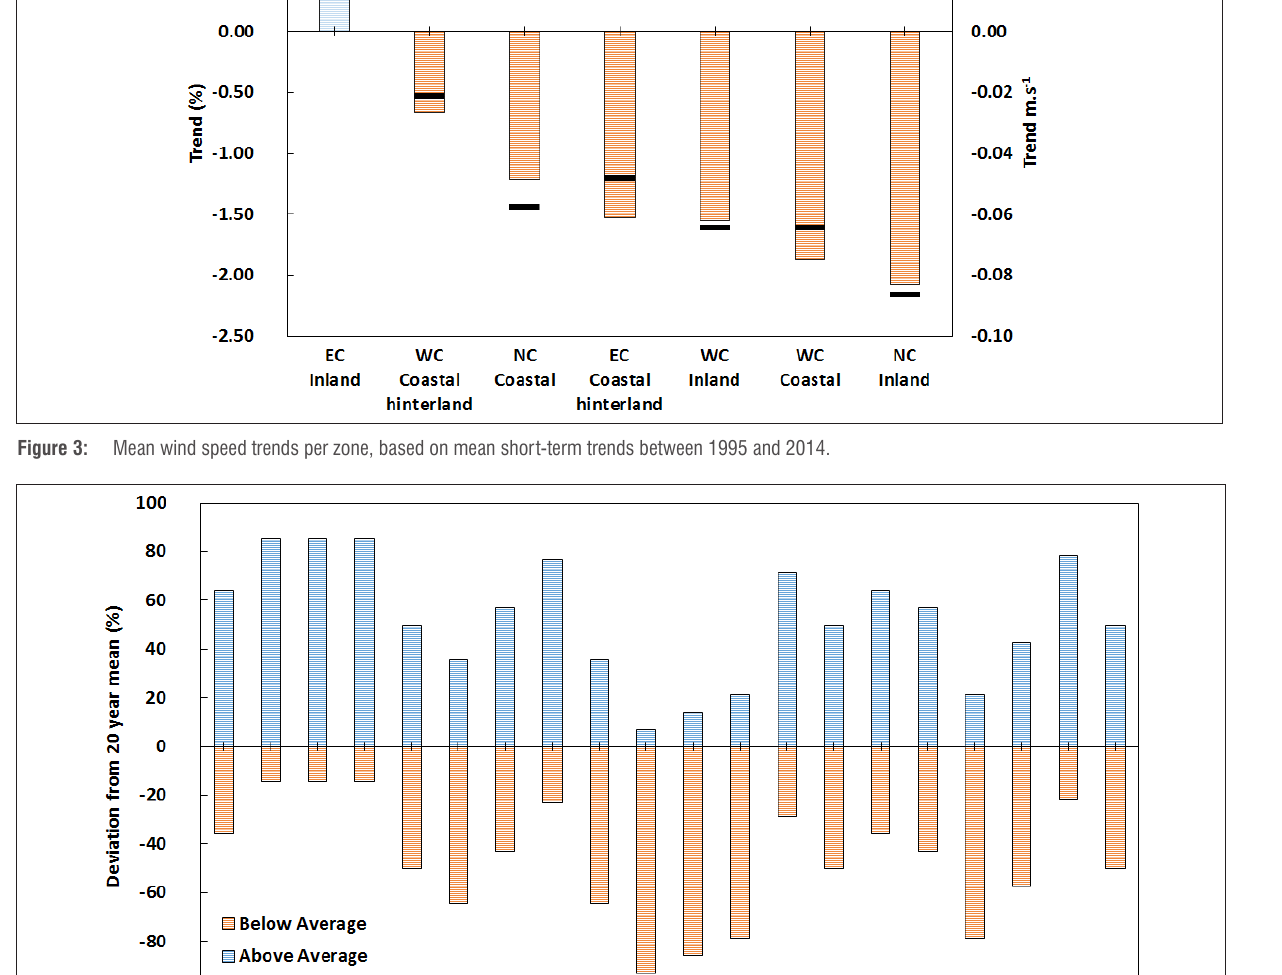
Over the 20-year period, mean annual wind speed trends were between -0.012 m/s/year (-0.31% pa) for Noupoort and 0.006 m/s/year (0.15% pa) for Langebaan, with a mean decrease across all stations of -0.002 m/s/year (-0.06%). The seasonal mean wind speed trends ranged from -0.016 m/s/year (-0.36% pa) recorded in summer, to 0.011 m/s/ year (0.26% pa) recorded in winter, both at Alexander Bay. Across all stations, mean seasonal wind speeds decreased by the highest margin (-0.006 m/s/year; -0.15% pa) during summer. For the 20 years assessed, 71% of stations recorded a decreasing mean wind speed trend (-0.004 m/s/year, -0.1% pa), while 29% recorded increasing mean trends (0.004 m/s/year, 0.1% pa). At a monthly scale, stations recorded a mean decrease of -0.0016 m/s/year (-0.043% pa) for September through February, and a mean increase of 0.001 m/s/year (0.035% pa) for March through August. The strongest mean decreasing trend of -0.0023 m/s/year (-0.06% pa) was recorded in January, while the strongest mean increasing trend of 0.002 m/s/year (0.06% pa) was recorded in May. A high percentage (86%) of stations recorded increasing wind speed trends during the autumn and winter months of March to August, while most stations (93%) recorded decreasing trends during the spring and summer months of September to February (Figure 7).